Question: Judging by this figure, is the value going up or going down?
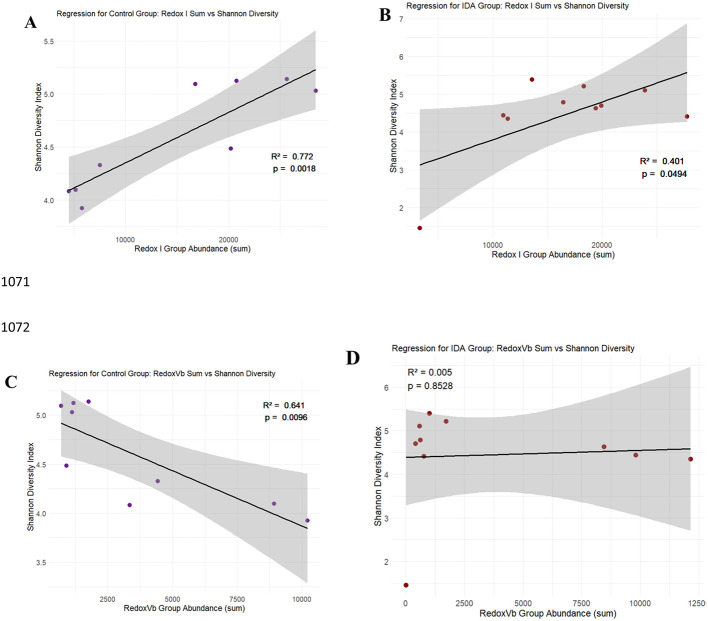
Answer: increasing